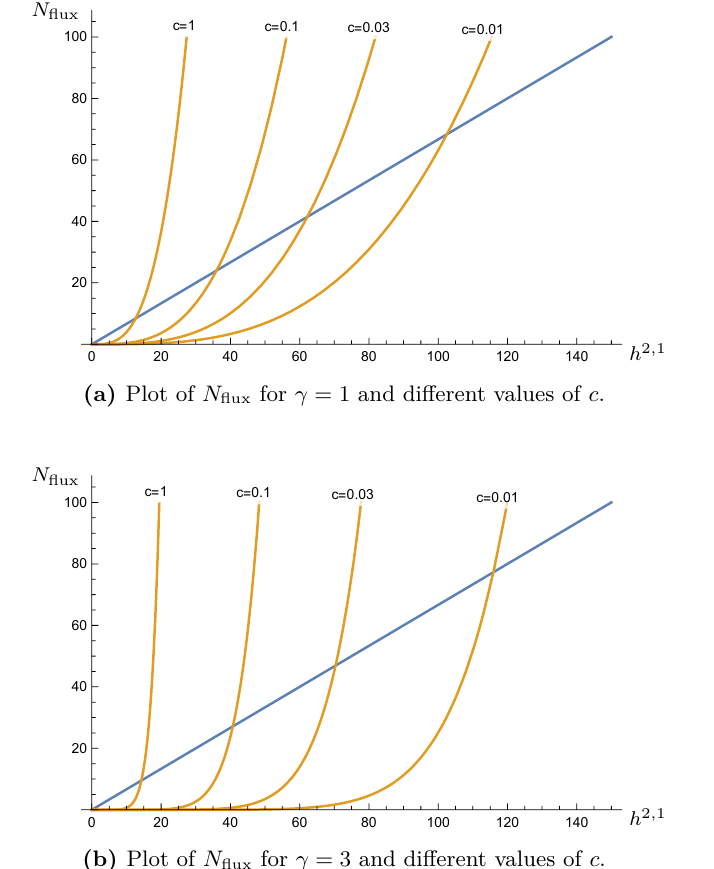
Figure 2. Comparison between the bound on N flux shown in equation (4.20) (orange curves) and the bound from the tadpole conjecture (1.1) for α = 1 / 3 (blue curve). In figure 2a the parameter γ is chosen as γ = 1 , while in figure 2b we have chosen γ = 3